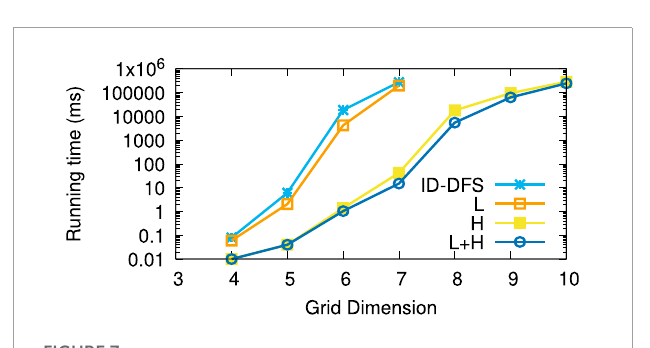
FIGURE 7 Average running times (in ms) for the type (b) (random links) grids.